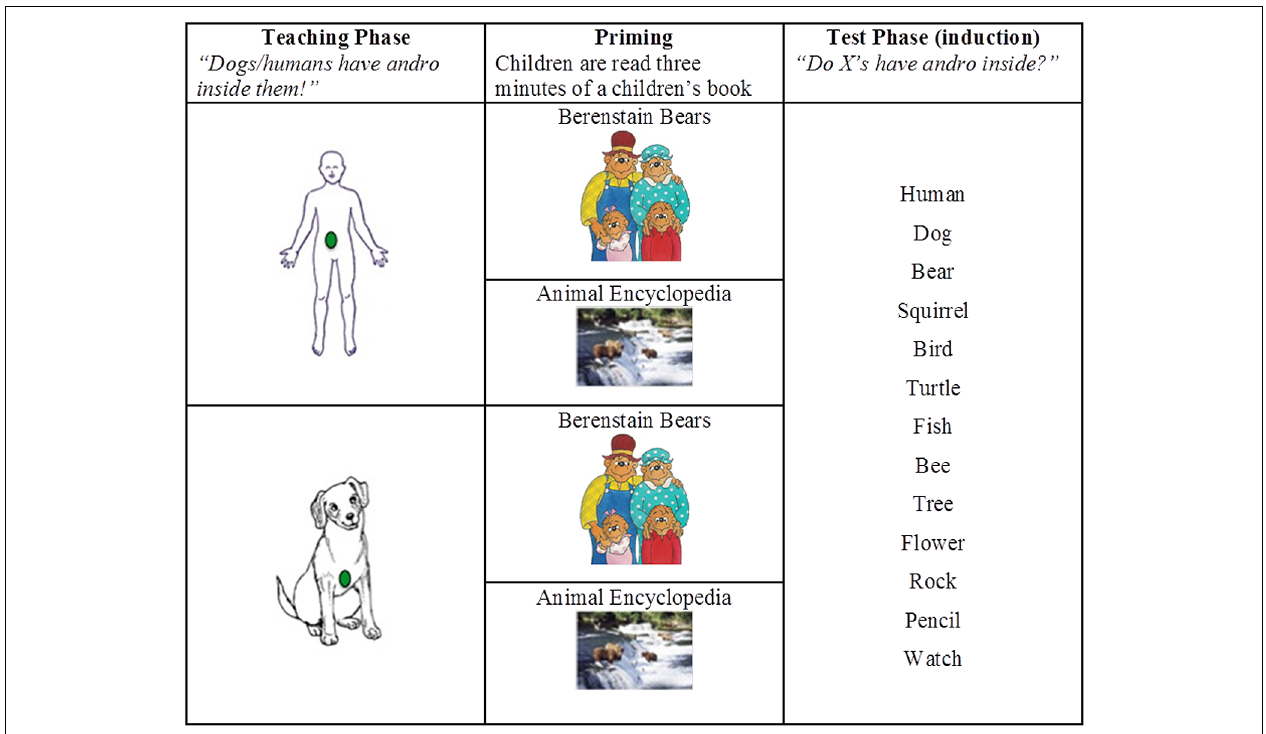
FIGURE 1 | Experimental design. During the teaching phase, children were presented with either a human or dog; during the priming phase children were read to from Berenstain Bears or Animal Encyclopedia. All children were presented with all target pictures during the test phase.